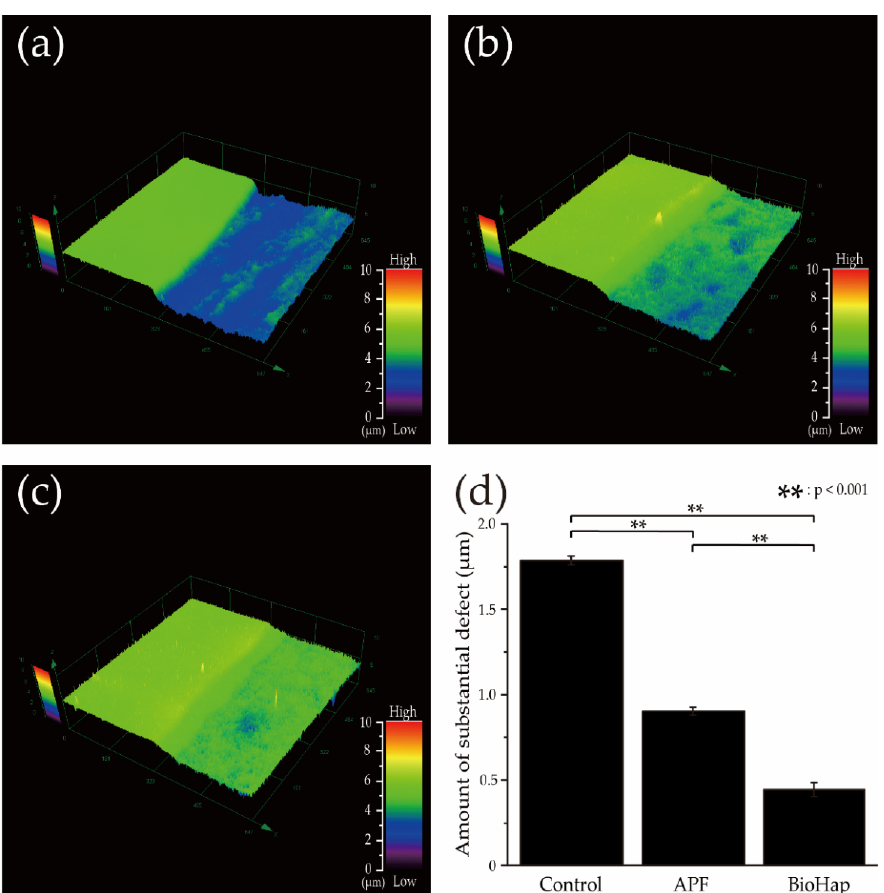
Figure 1. Comparison of non-decalcified and decalcified interface images and measurements of substantial defects after the acid challenge. ( a ) Control, ( b ) APF, and ( c ) BioHap groups. ( a – c ) show the non-decalcified control surface on the left and decalcified experimental surface on the right. The contrast plane was used as the reference plane. ( d ) Average ± SD of substantial defect ( n = 9). The horizontal axis indicates the various preventive treatments, and the vertical axis indicates the step ( µ m) between the control and experimental surfaces. Color scale bars represent 0–10 µ